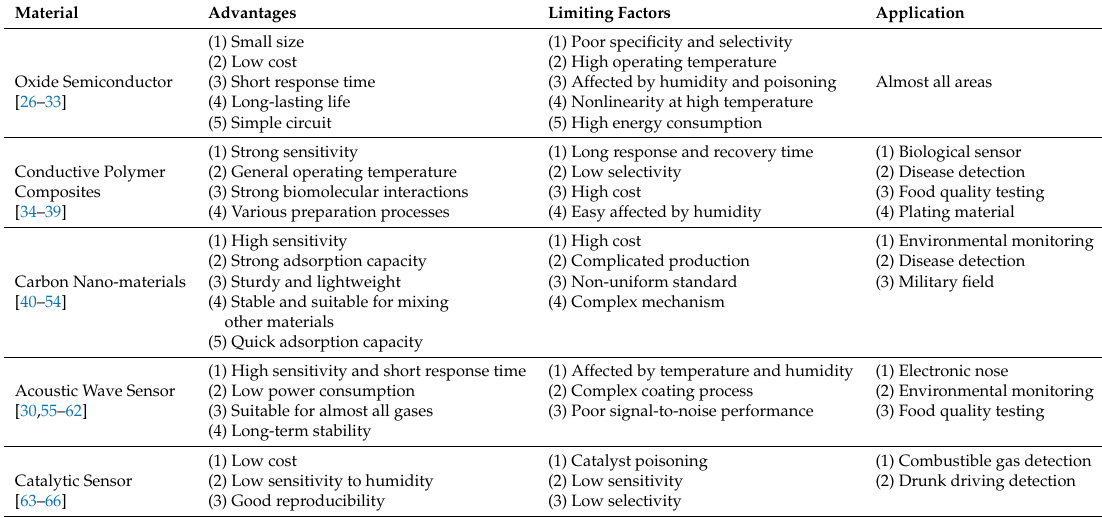
Table 2. Summary of Gas Sensitive Materials Which Used in Sensors